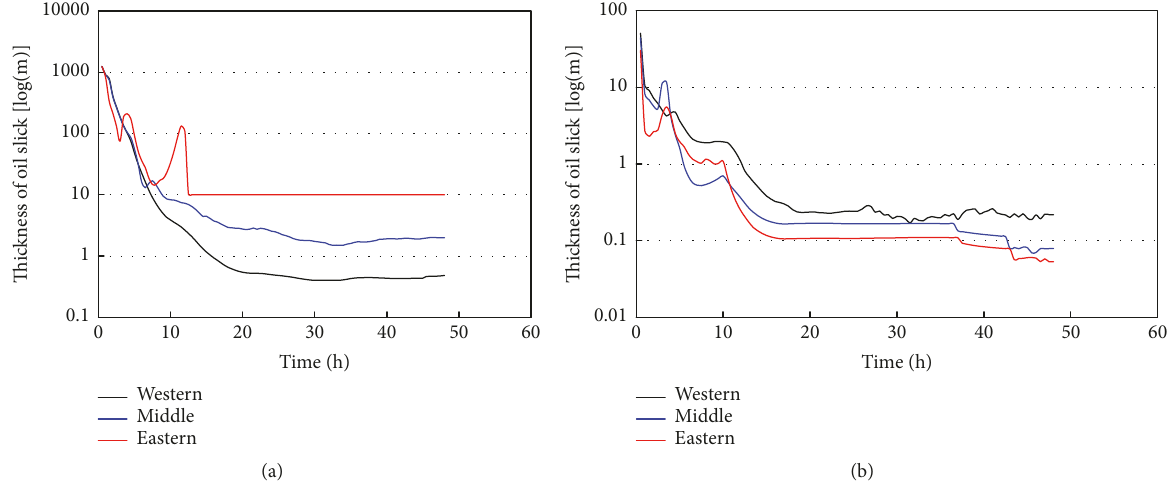
Figure 26: Slick thickness of instantaneous (a) and continuous (b) oil spills versus time in different spill locations (black line for the western spill location, blue line for the middle spill location, and red line for the eastern spill location) under the influence of northeast winds.